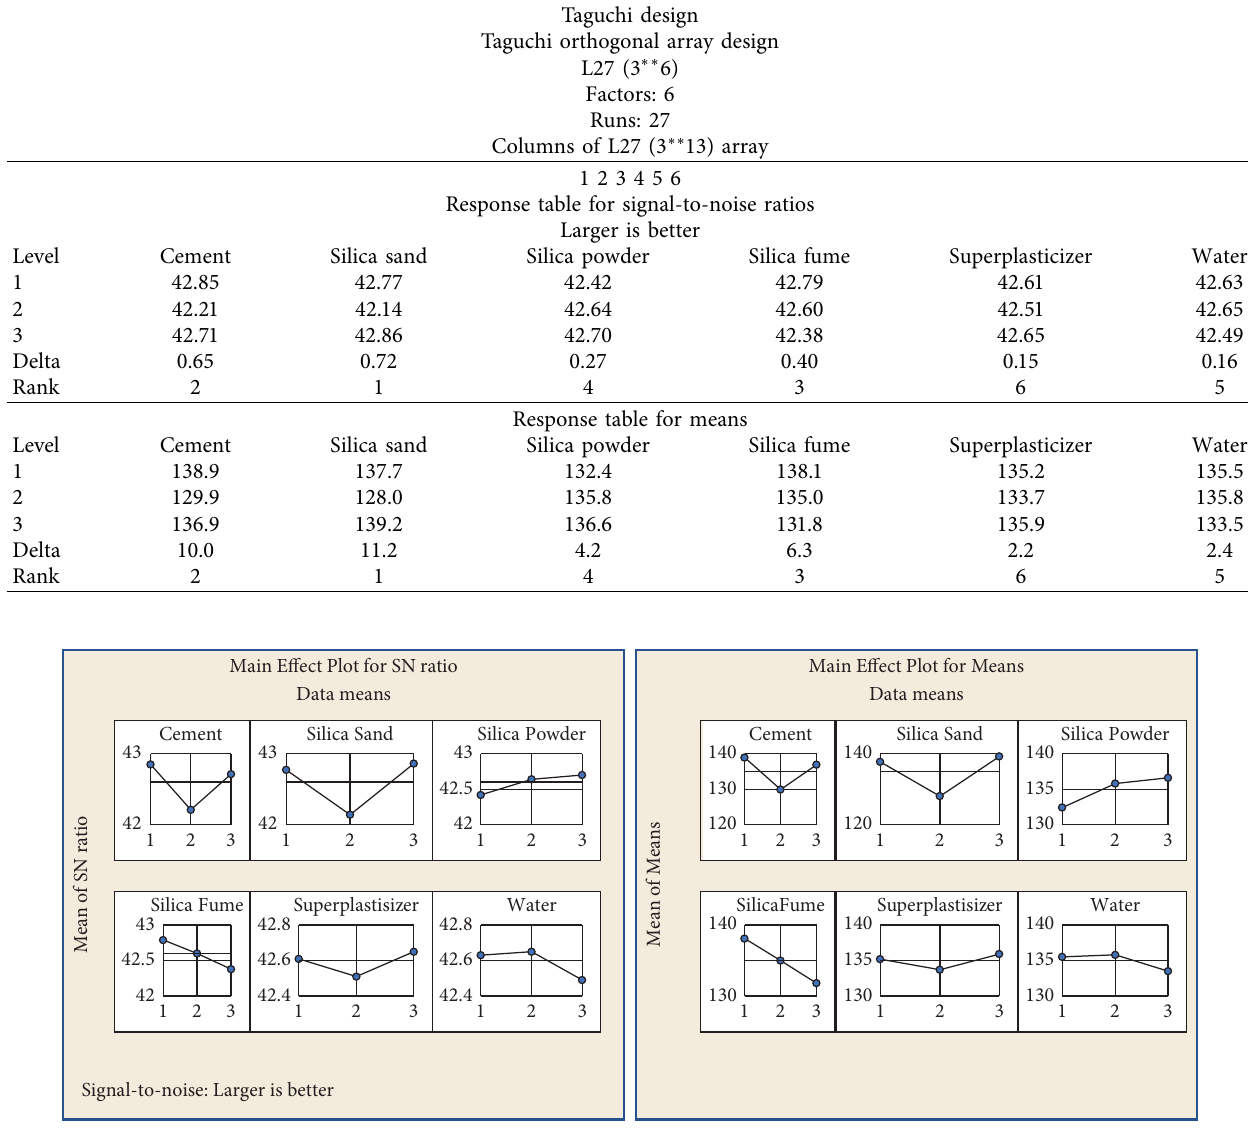
Figure 4: Main efects plot for SN ratios and means. Table 14: Optimal RPC concrete mix design recommended by Minitab for compressive strength.